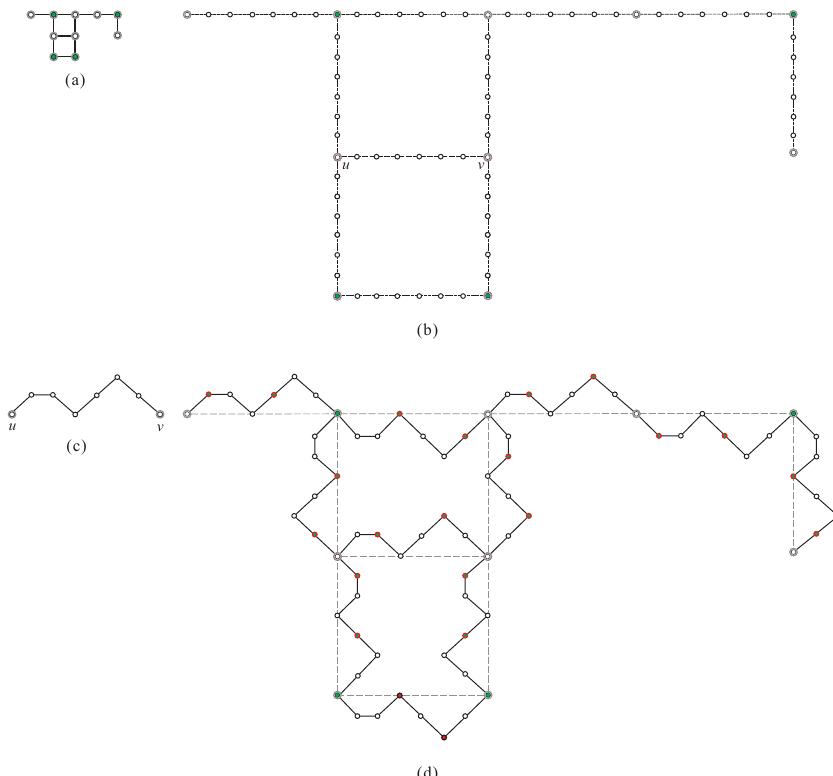
Figure 4. ( a ) A grid graph G g , ( b ) a grid graph G (cid:48) g that magnifies each edge of G g by a factor of seven, ( c ) a snake ( u , v ) -path S ( u , v ) with eight vertices, and ( d ) a diagonal supergrid graph G d constructed from G (cid:48) g by replacing each enlarged path with a snake path in ( c ), where the solid lines represent edges of G g and G d , double circles represent the vertices of G g , and filled circles represent the vertices in a dominating set of G g or G d